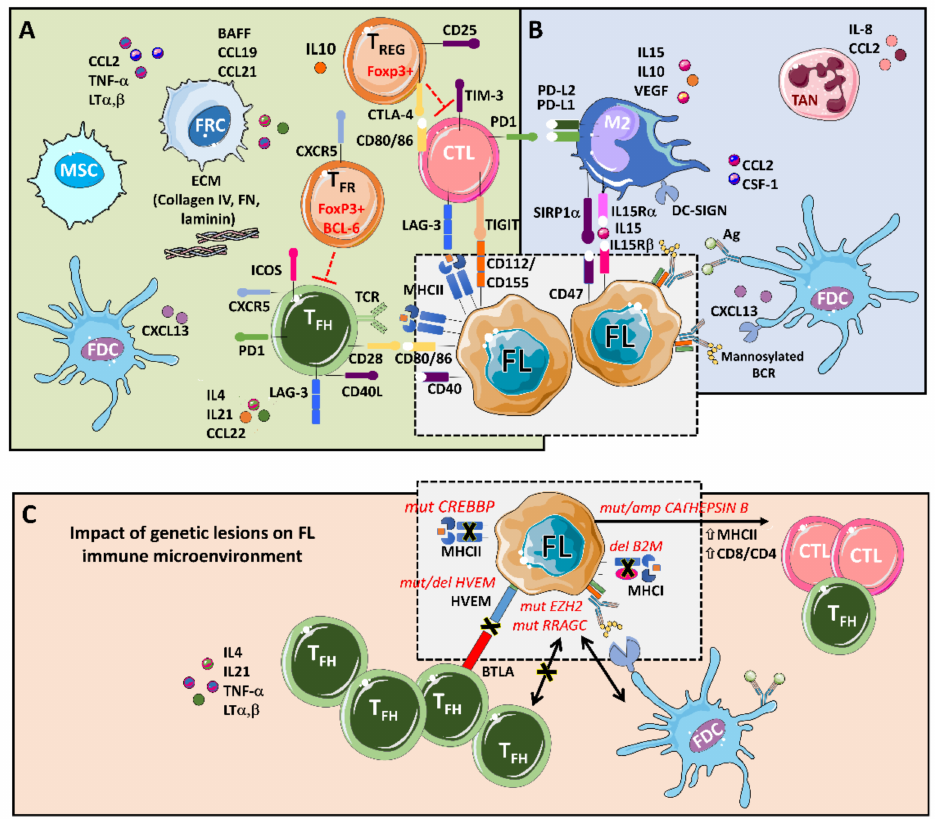
Figure 1. An integrative view of follicular lymphoma (FL) microenvironment and its crosstalk with genetic drivers. ( A ) FL is highly infiltrated with several T cell subpopulations, where T FH are fundamental players through MHC II and CD40L, while immunosuppressive T REG hamper cytotoxic T cells (CTLs) activation. Fibroblastic reticular cells (FRCs) also participate in immunosuppression by secreting extracellular matrix (ECM) proteins that regulate T cell trafficking and cooperate with T FH . ( B ) FL cells favor the recruitment of monocytes through CCL2 and CSF-1 that differentiate and polarize mostly into M2-like macrophages expressing PD-L1 and PD-L2 and dampening CTLs cytotoxic activity. Both macrophages and FDCs activate B cell receptors (BCRs) through lectins binding to mannosylated BCR. Likewise, FDCs also activate BCRs through the presentation of immunocomplexes to FL cells. Neutrophils are recruited through IL8 secretion in the FL niche and support lymphoma growth. ( C ) Several genetic alterations corrupt the microenvironment to better support FL. Mutations in CREBBP and deletions in B2M genes reduce MHC II and MHC I expression, respectively. On the contrary, aberrant CATHEPSIN B leads to an increase in MHC II expression and CD8 expansion. Both EZH2 and RRAGC mutations reduce the need for T FH help making FL cells more dependent on FDCs, while disruption of the HVEM–BTLA axis allows uncontrolled T FH support to FL